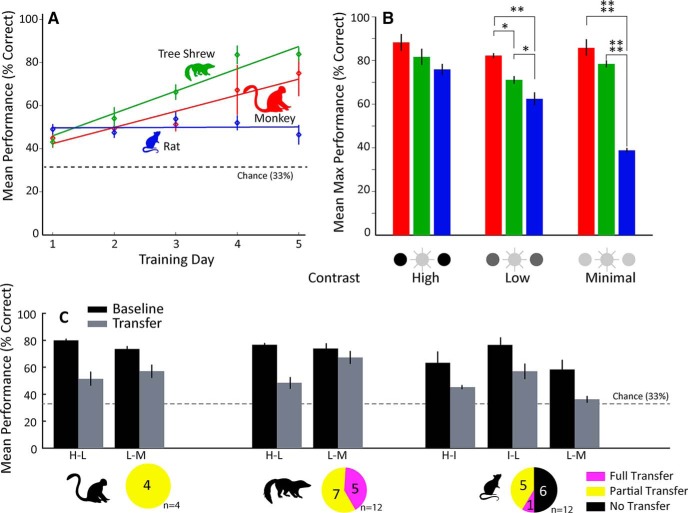
Behavioral performance. A, Mean performance over the first 5 d of training for all species shown. Initially, all species are at a similar level of performance and begin to diverge on day 3. At day 5, the monkeys and tree shrews are still equivalent, while the rats have fallen behind. B, We calculated the maximum performance for each condition by averaging the best 3 d for each animal for that condition. Asterisks denotes significance (*p < 0.05, **p < 0.01, ****p < 0.001). C, To quantify transfer, we compared the mean of the final three sessions of the prior contrast condition to the first three sessions of the subsequent contrast condition. Mean and SEM performance values are shown for a representative animal of each species. The pie charts illustrate the number of cases of transfer observed in that species, i.e., the number of transfer conditions multiplied by the number of subjects for each species. For statistics and description of transfer conditions, see text.